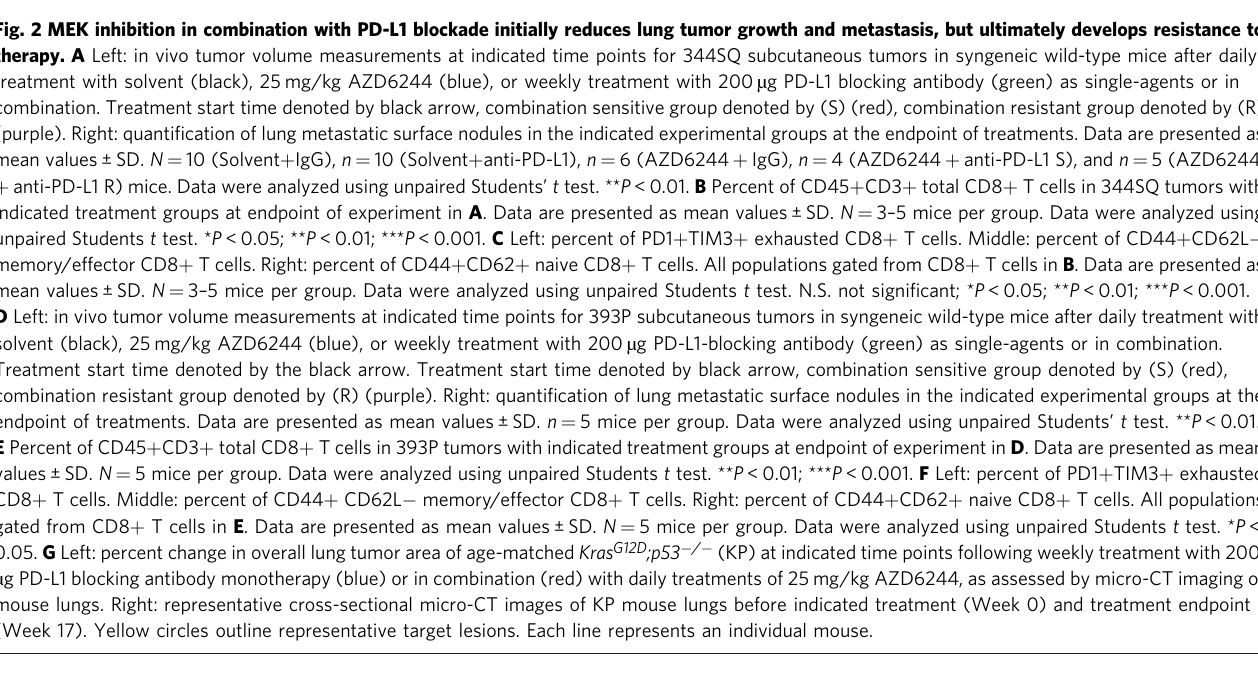
Fig. 2 MEK inhibition in combination with PD-L1 blockade initially reduces lung tumor growth and metastasis, but ultimately develops resistance to therapy. A Left: in vivo tumor volume measurements at indicated time points for 344SQ subcutaneous tumors in syngeneic wild-type mice after daily treatment with solvent (black), 25 mg/kg AZD6244 (blue), or weekly treatment with 200 µ g PD-L1 blocking antibody (green) as single-agents or in combination. Treatment start time denoted by black arrow, combination sensitive group denoted by (S) (red), combination resistant group denoted by (R) (purple). Right: quanti fi cation of lung metastatic surface nodules in the indicated experimental groups at the endpoint of treatments. Data are presented as mean values± SD. N = 10 (Solvent + IgG), n = 10 (Solvent + anti-PD-L1), n = 6 (AZD6244 + IgG), n = 4 (AZD6244 + anti-PD-L1 S), and n = 5 (AZD6244 + anti-PD-L1 R) mice. Data were analyzed using unpaired Students ’ t test. ** P < 0.01. B Percent of CD45 + CD3 + total CD8 + T cells in 344SQ tumors with indicated treatment groups at endpoint of experiment in A . Data are presented as mean values ± SD. N = 3 – 5 mice per group. Data were analyzed using unpaired Students t test. * P < 0.05; ** P < 0.01; *** P < 0.001. C Left: percent of PD1 + TIM3 + exhausted CD8 + T cells. Middle: percent of CD44 + CD62L − memory/effector CD8 + T cells. Right: percent of CD44 + CD62 + naive CD8 + T cells. All populations gated from CD8 + T cells in B . Data are presented as mean values ± SD. N = 3 – 5 mice per group. Data were analyzed using unpaired Students t test. N.S. not signi fi cant; * P < 0.05; ** P < 0.01; *** P < 0.001. D Left: in vivo tumor volume measurements at indicated time points for 393P subcutaneous tumors in syngeneic wild-type mice after daily treatment with solvent (black), 25 mg/kg AZD6244 (blue), or weekly treatment with 200 µ g PD-L1-blocking antibody (green) as single-agents or in combination. Treatment start time denoted by the black arrow. Treatment start time denoted by black arrow, combination sensitive group denoted by (S) (red), combination resistant group denoted by (R) (purple). Right: quanti fi cation of lung metastatic surface nodules in the indicated experimental groups at the endpoint of treatments. Data are presented as mean values ± SD. n = 5 mice per group. Data were analyzed using unpaired Students ’ t test. ** P < 0.01. E Percent of CD45 + CD3 + total CD8 + T cells in 393P tumors with indicated treatment groups at endpoint of experiment in D . Data are presented as mean values ± SD. N = 5 mice per group. Data were analyzed using unpaired Students t test. ** P < 0.01; *** P < 0.001. F Left: percent of PD1 + TIM3 + exhausted CD8 + T cells. Middle: percent of CD44 + CD62L − memory/effector CD8 + T cells. Right: percent of CD44 + CD62 + naive CD8 + T cells. All populations gated from CD8 + T cells in E . Data are presented as mean values ± SD. N = 5 mice per group. Data were analyzed using unpaired Students t test. * P < 0.05. G Left: percent change in overall lung tumor area of age-matched Kras G12D ;p53 − / − (KP) at indicated time points following weekly treatment with 200 µ g PD-L1 blocking antibody monotherapy (blue) or in combination (red) with daily treatments of 25 mg/kg AZD6244, as assessed by micro-CT imaging of mouse lungs. Right: representative cross-sectional micro-CT images of KP mouse lungs before indicated treatment (Week 0) and treatment endpoint (Week 17). Yellow circles outline representative target lesions. Each line represents an individual